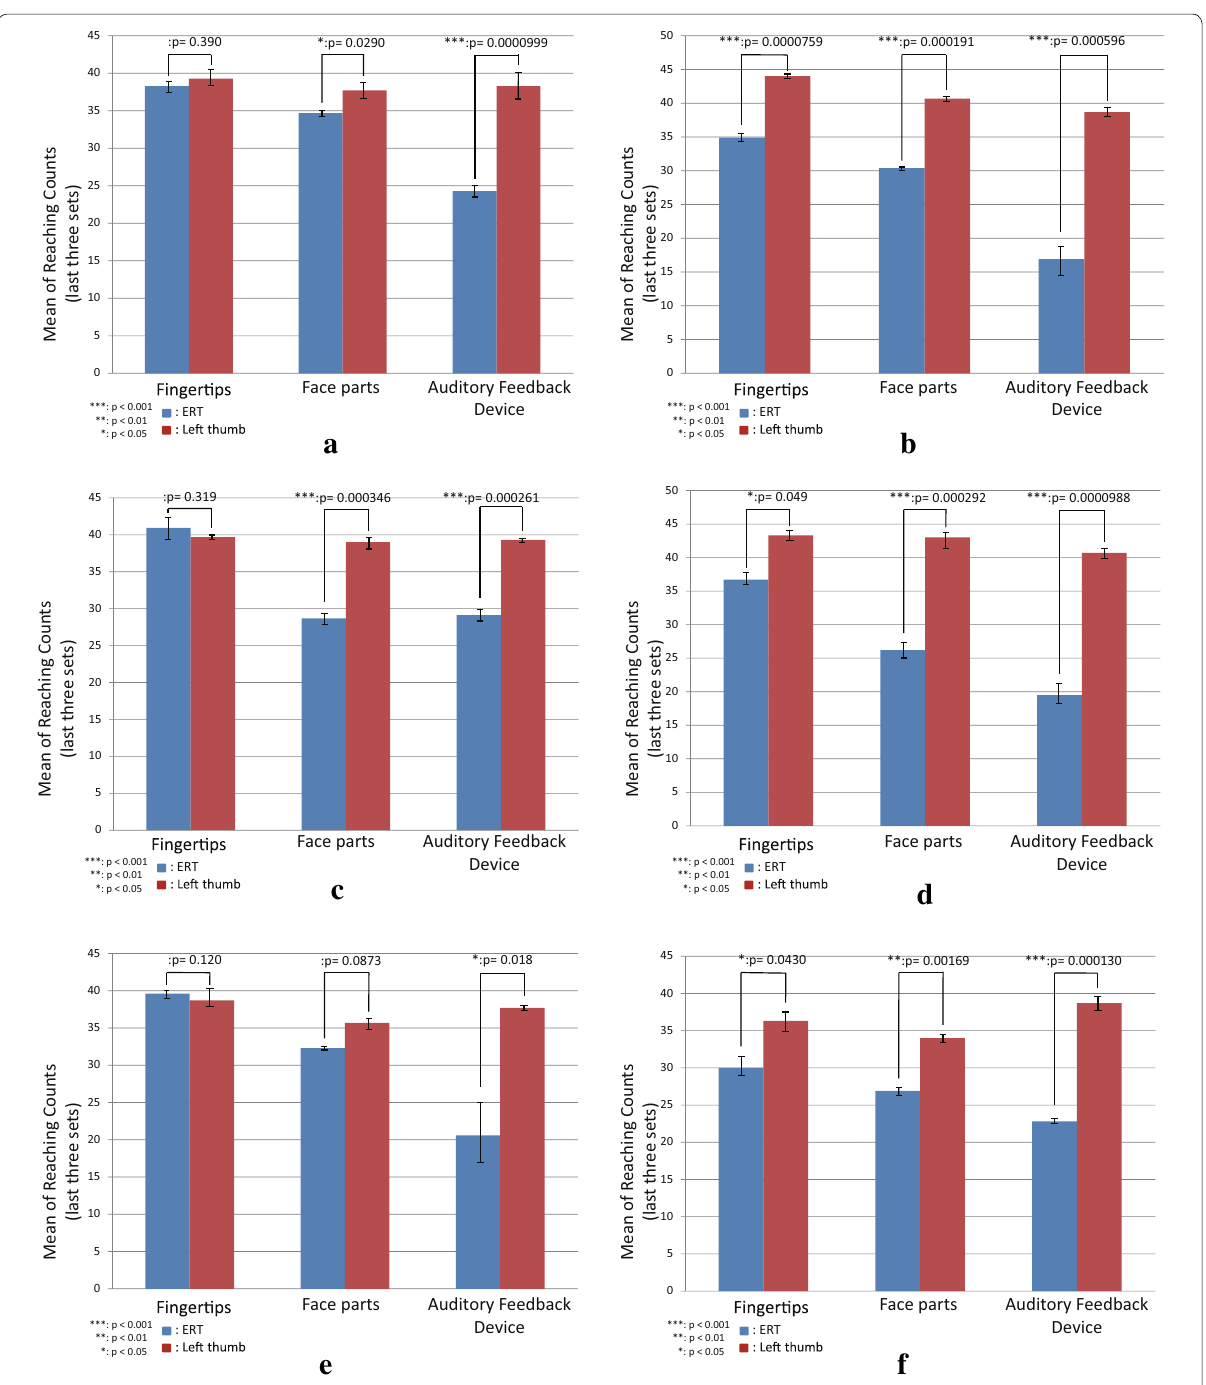
Fig. 9 Comparison between the successful reaching counts by the ERT (mean value of last three sets) and the reaching counts by the left thumb (mean value of last three sets) for the six subjects a , b , c , d , e and f , under three distinct conditions. The blue bar is the average number of successful reaching counts in last three sets by the ERT. The red bar is the average number of reaching counts in last three sets by the left